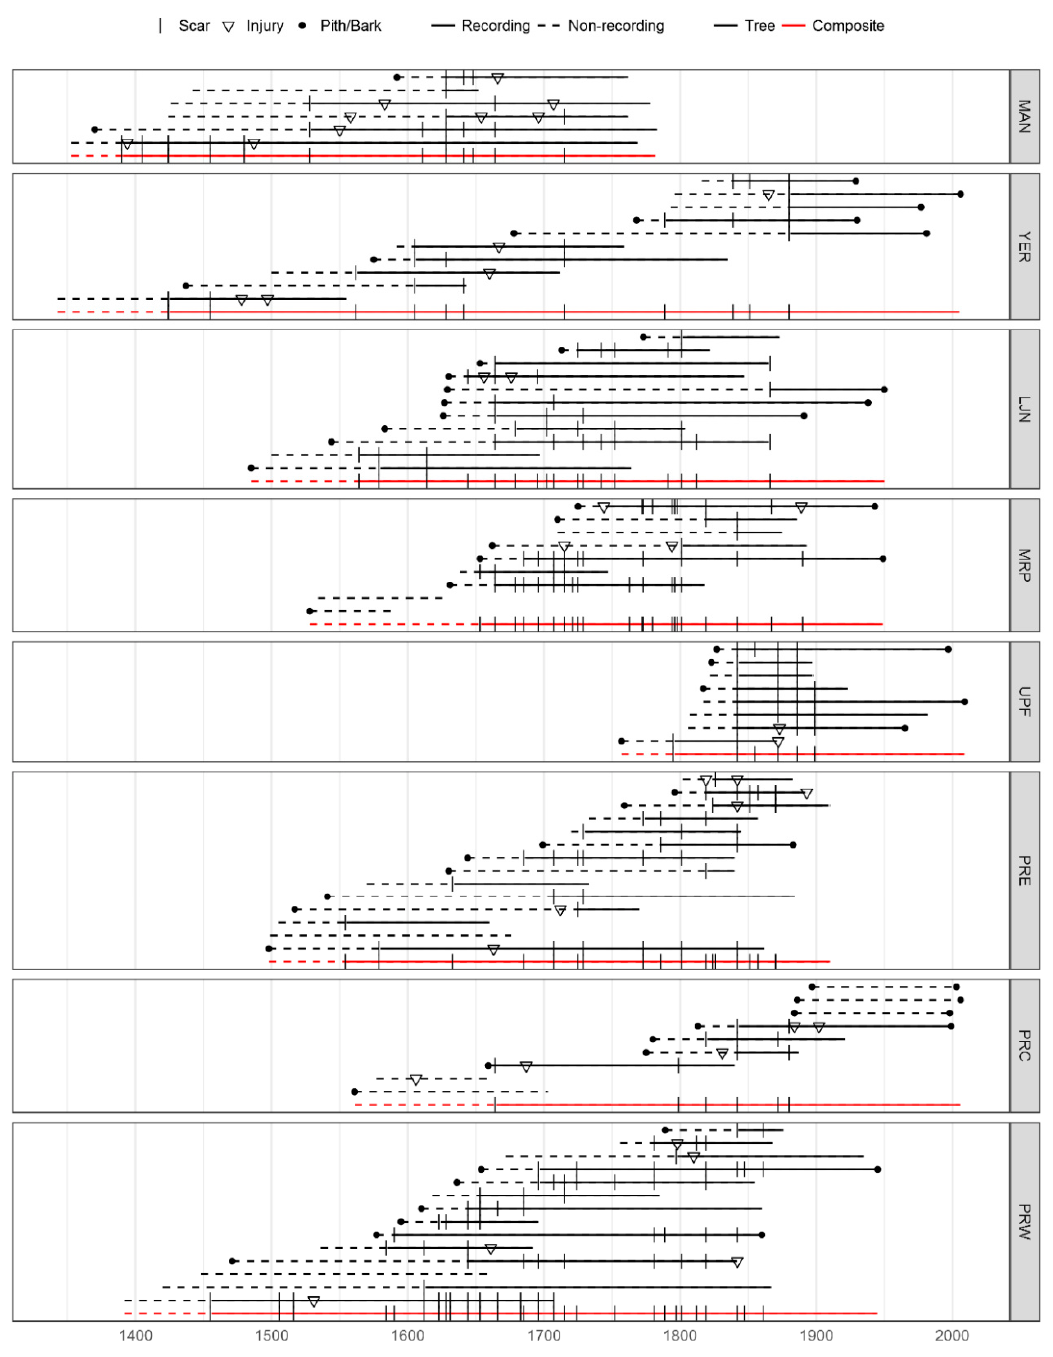
Figure 3. The fire charts for eight tree-ring fire-scar plots in the Taos Valley Watersheds. The black horizontal lines represent individual trees. The red horizontal lines are the plot composites, which include all recorded fires from all trees at a plot. A tree begins “recording” fires after it sustains a wound that removes the bark, which makes it more likely to record subsequent fires as scars. Injuries are anatomical anomalies that may be fire-caused but cannot be confidently attributed to a fire. Examples of injuries include thin latewood, heavy resin ducts, and unusual eroded cracks on the same edge of a sample where other fire scars were recorded. Injuries are not included in the reported fire statistics.